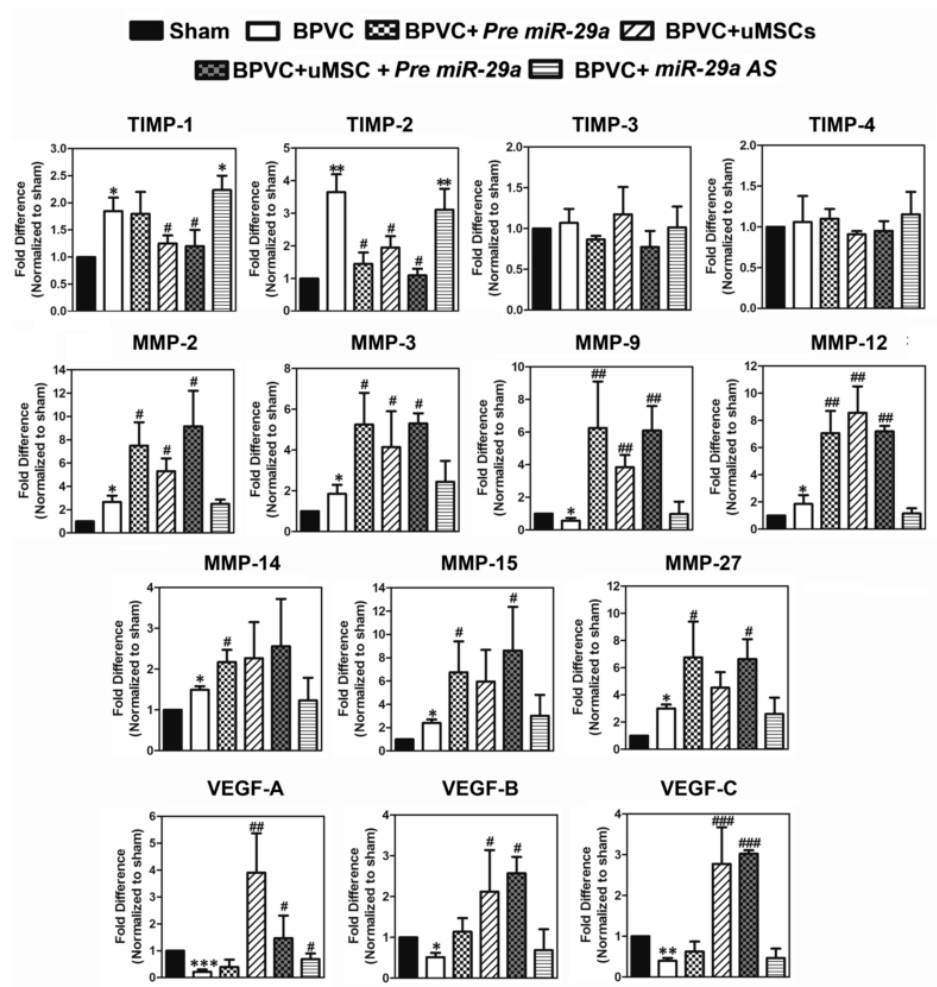
Figure 4. Effects of exogenously introduction of miR-29a or transplantation of uMSCs on the expression of mouse tissue inhibitors of metalloproteinases (TIMPs), matrix metalloproteinases (MMPs), and vascular endothelial growth factors (VEGF) in isolated gastrocnemius muscles underwent BPVC-induced ischemic injury. Tissue extracts were collected from gastrocnemius muscles on day 7 post saline or BPVC injection, or after four days of Pre miR-29a , miR-29a AS, and uMSC transplantation 72 h following BPVC-injection. The protein levels of anti-angiogenic factors TIMPs and known pro-angiogenic factors MMPs and VEGFs, responsible for cleaving various extracellular proteins to enhance the tube formation and promote vascular development, with each group of mice were determined using the Quantibody Mouse Angiogenesis Array ( n = 6/group). Data were given as means ± SD; * p < 0.05, ** p < 0.01, *** p < 0.001 for the BPVC group vs. the Sham group; # p < 0.05, ## p < 0.01, ### p < 0.001 for the BPVC group vs. the Sham group; * p < 0.05, ** p < 0.01 for the BPVC + Pre miR-29a group, the BPVC + miR-29a AS group, the BPVC + uMSC group, the BPVC + uMSC + Pre miR-29a group vs. the BPVC group.